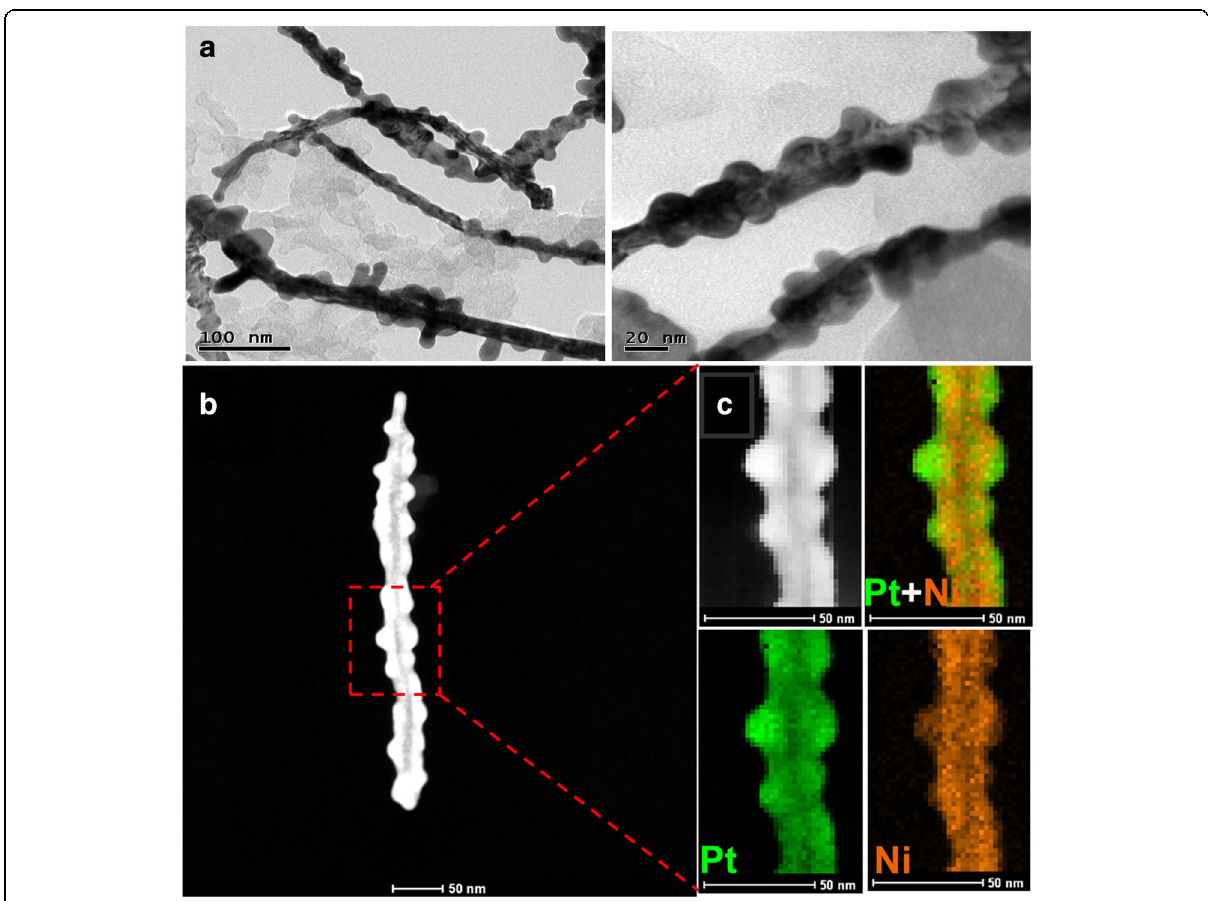
Fig. 1 a TEM images, b HAADF-STEM images, and c STEM-EDS elemental mapping of Pt-Ni jagged-like